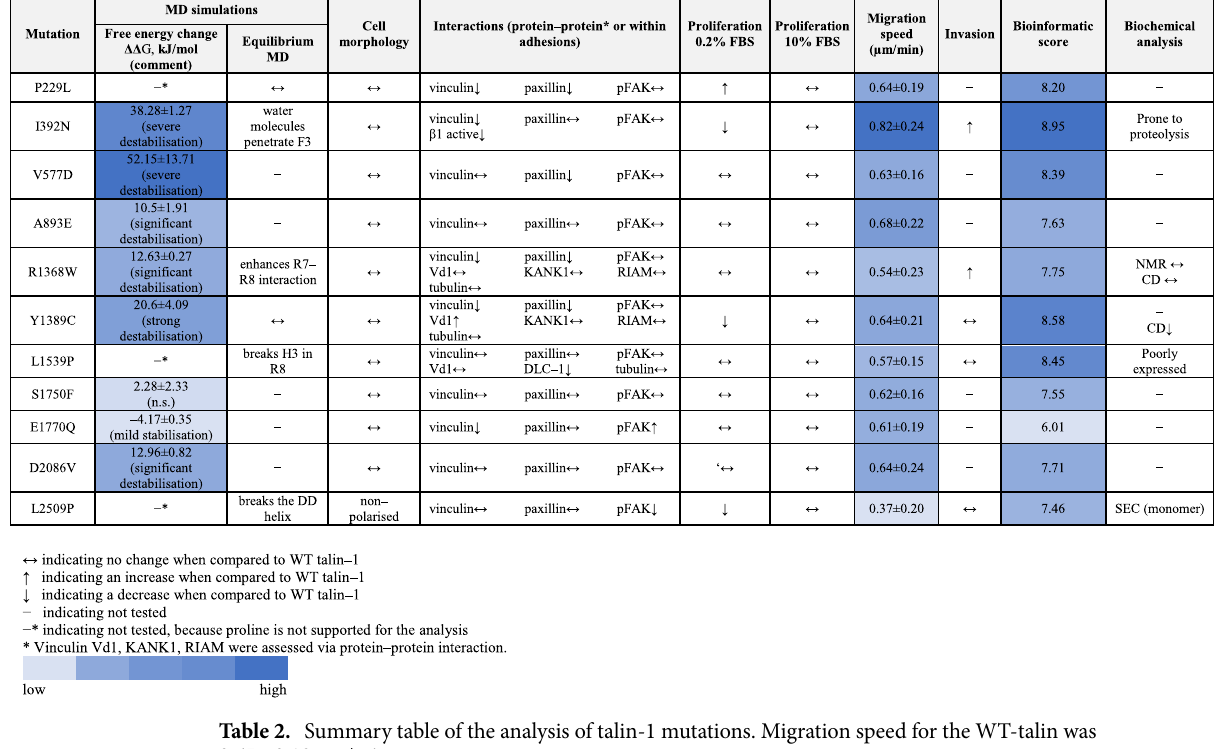
Table 2. Summary table of the analysis of talin-1 mutations. Migration speed for the WT-talin was 0.65 ± 0.18